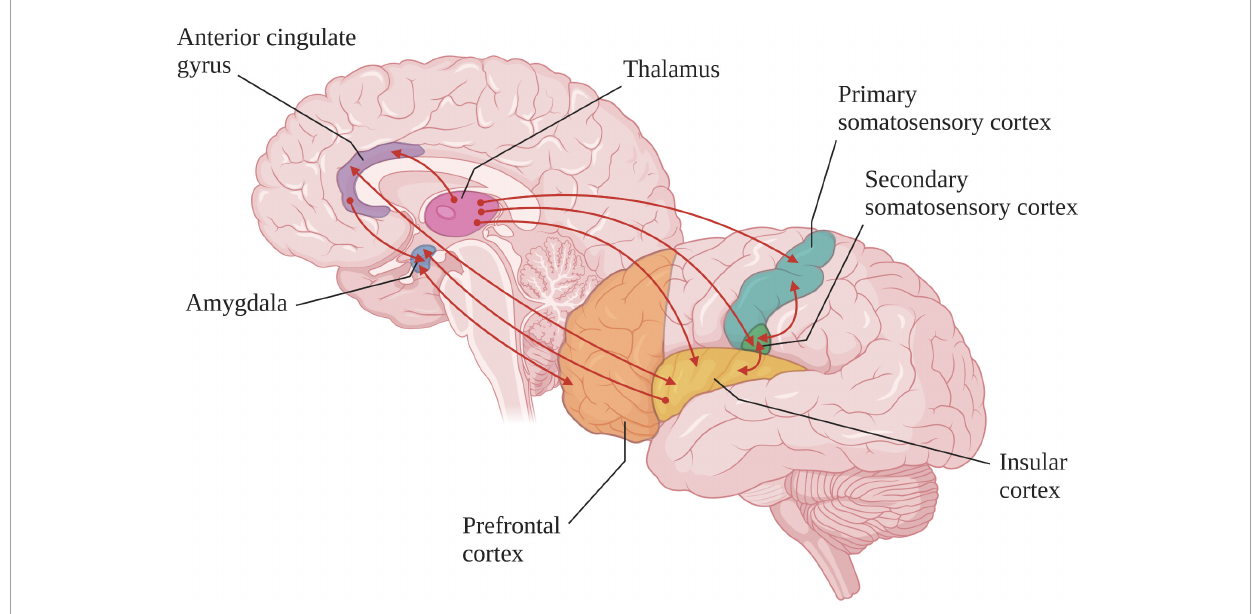
FIGURE3 Cortical and subcortical regions involved in the pain-related neuromatrix (created with BioRender.com). In healthy subjects and MCS or LIS patients the functional connections (red lines) are preserved whereas in “true” UWS patients the somatosensory cortex is activated in isolation [based on Bouhassira et al. (2005) and Bagnato et al.